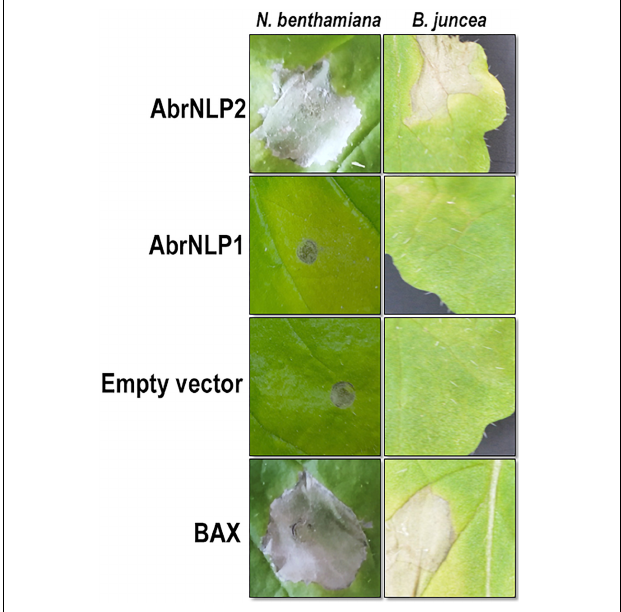
FIGURE 4 | Agroinfiltration of AbrNLP1 and AbrNLP2 in N. benthamiana and B. juncea . Transient expression of AbrNLP1 and AbrNLP2 in both host and non-host species. BAX was used as a positive control for induction of cell death and empty vector (pGWB408) was used as a negative control.